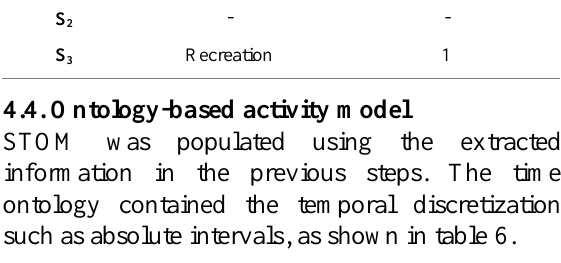
Table 6. Temporal discretization of time ontology.